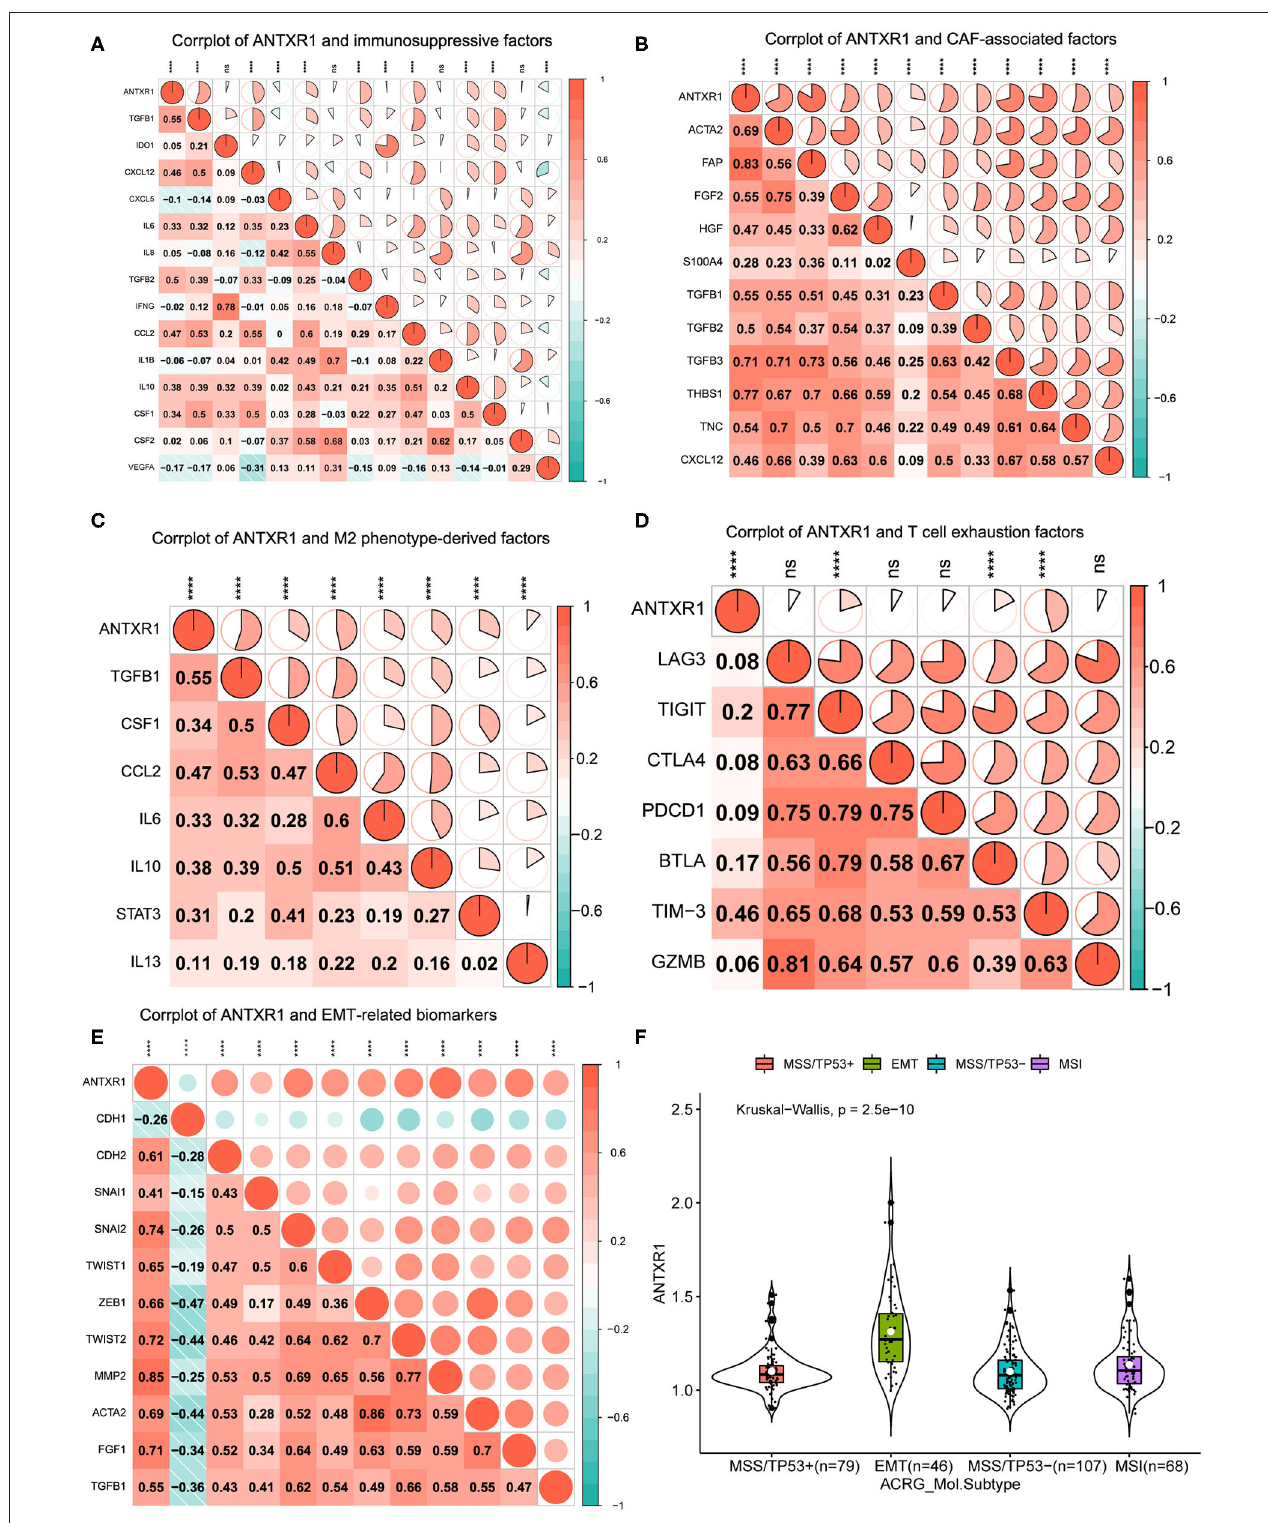
FIGURE 6 | ANTXR1 contributes to immunosuppression and prompt EMT. (A) Corrplot between ANTXR1 and immunosuppressive cell recruitment factors. (B) Corrplot between ANTXR1 and cancer-associated fibroblast (CAF)-related factors. (C) Corrplot between ANTXR1 and M2 phenotype-driving factors. (D) Corrplot between ANTXR1 and exhausted T cell receptors. (E) Corrplot between ANTXR1 and common biomarkers of EMT. (F) Box plot of ANTXR1 expression levels in different ACRG molecular subtypes. Box plot elements (center line, median; box boundaries, upper and lower quartiles; whiskers, maximum and minimum). EMT, epithelial–mesenchymal transition; ACRG, Asian Cancer Research Group. * P < 0.05, ** P < 0.01, *** P < 0.001, **** P < 0.0001, ns P > 0.05.